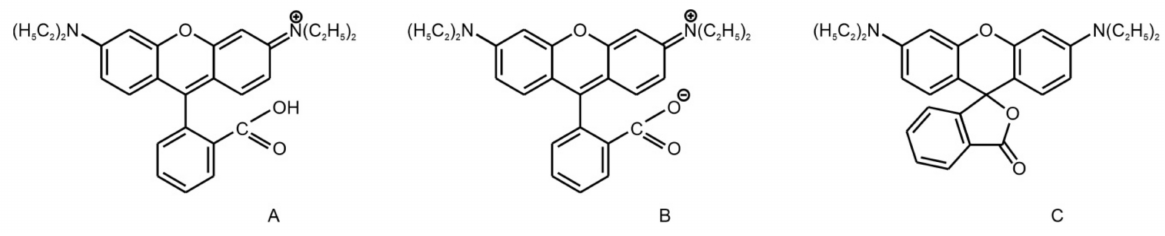
Figure 4. The speciation of RB: cation ( A ), zwitterion ( B ), and lactone ( C